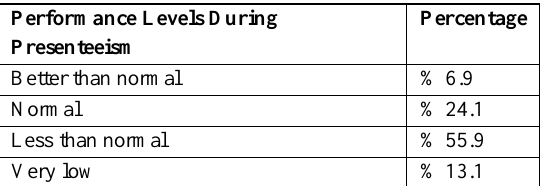
Table 17: Performance Perceptions of Employees during Presenteeism Performance Levels During